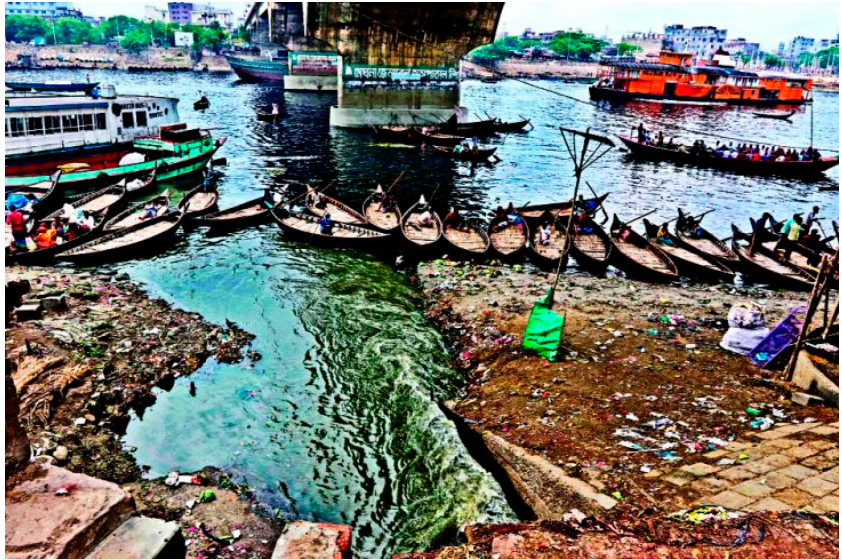
Figure 2. The usual quality of wastewater falling through the sluice gates.